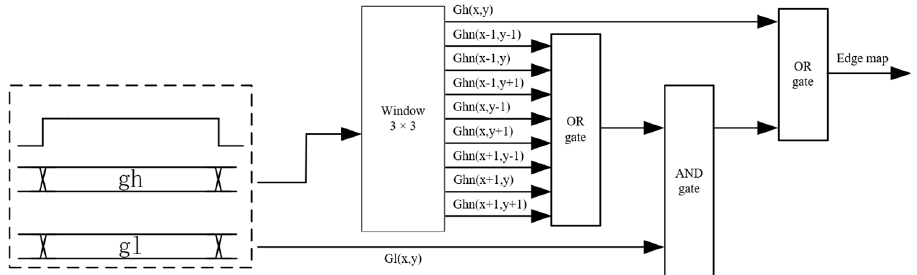
Figure 17. Architecture of hysteresis thresholding.